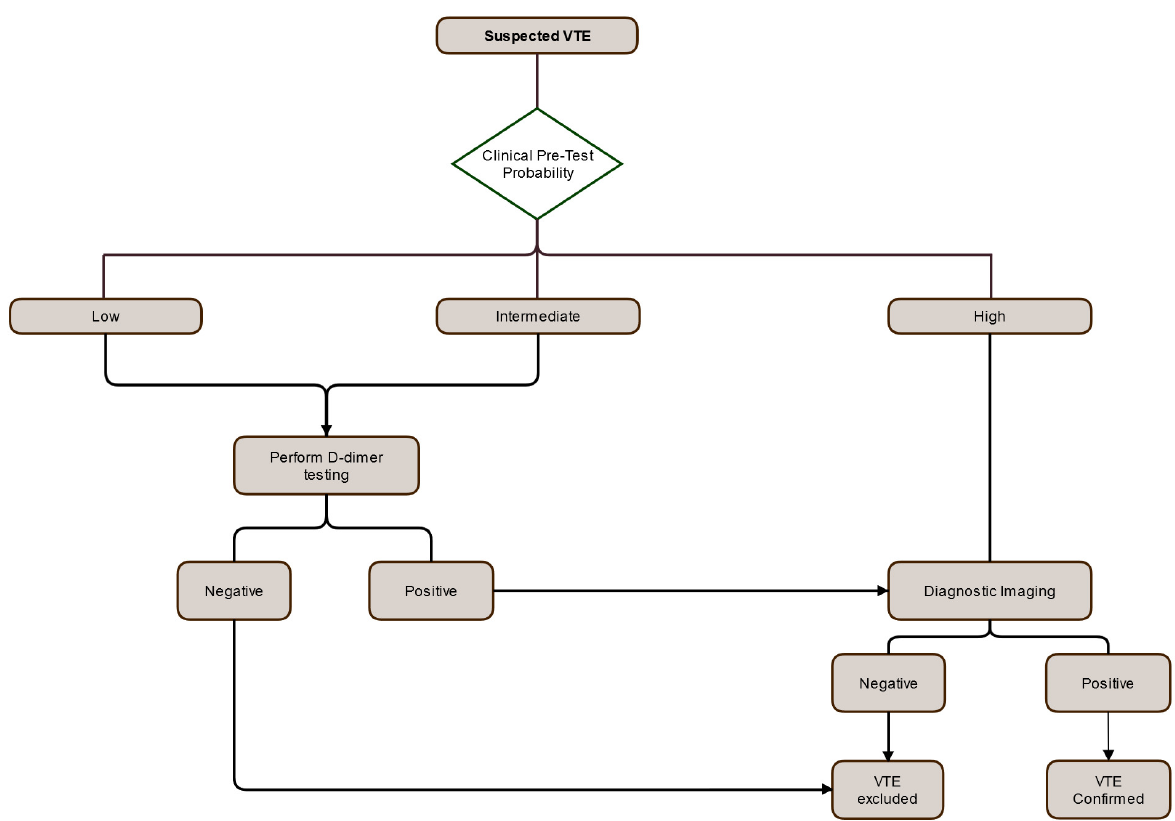
Figure 3. Approach to venous thromboembolism (VTE) diagnosis using pre-test probability, D-dimer and diagnostic imaging. Diagnostic algorithm in patients with suspected deep vein thrombosis (DVT) or pulmonary embolism (PE). The first step is assessment of the clinical pretest probability. Patients with a low or intermediate pretest probability should undergo D-dimer testing. A negative D-dimer excludes the diagnosis, whereas those with a positive D-dimer test should undergo diagnostic imaging with compression ultrasound and computed tomography pulmonary angiography to rule out DVT and PE, respectively. Patients with a high pretest probability require